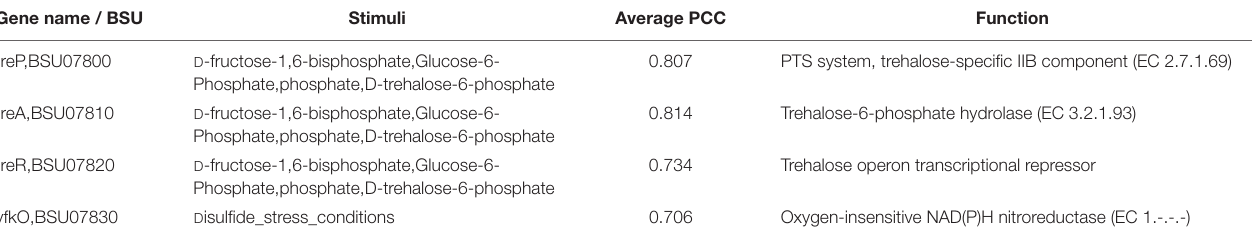
TABLE 7 | Atomic Regulon 332.